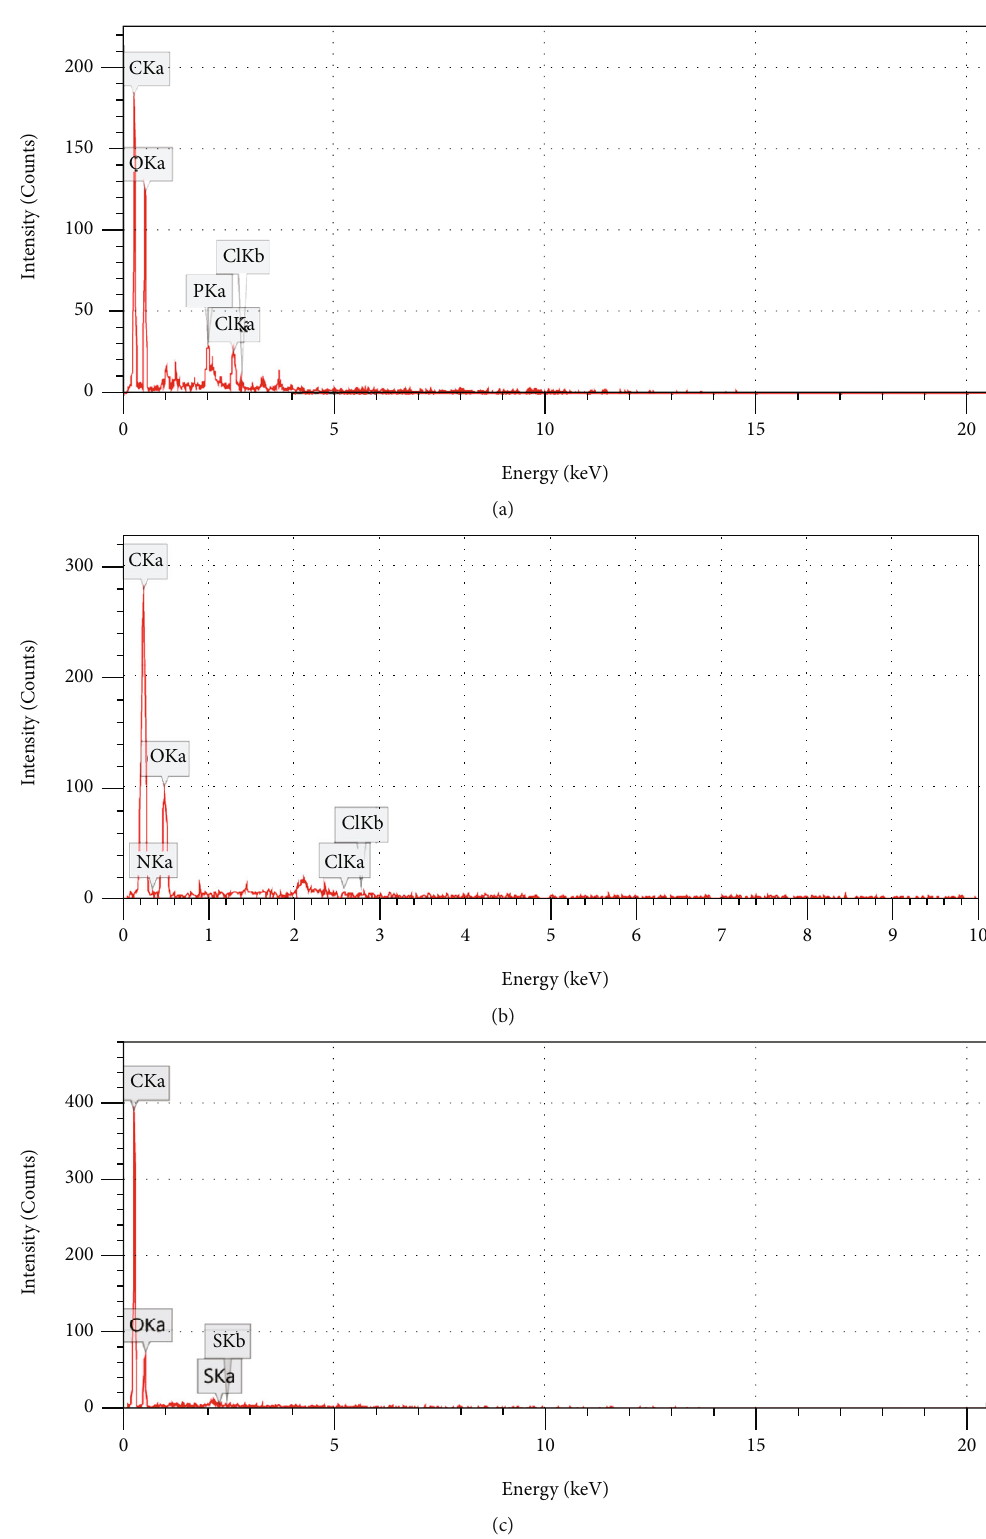
Figure 2: EDX plots of pure ((a) PFS) and treated ((b) NAFS and (c) SAFS) fennel seed